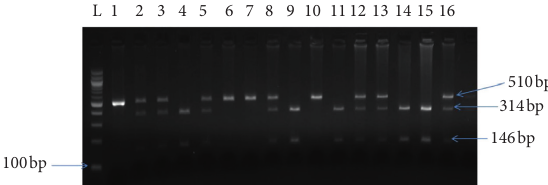
Figure 2: Amplified product of the -844G/A polymorphism through a PCR-RFLP. L: 100 bp ladder, lanes 1, 6, 7, and 10 ho- mozygous mutant, lanes 2, 3, 5, 8, 12, 13, and 16: heterozygous, and lanes 4, 9, 11, 14, and 15: homozygous normal.